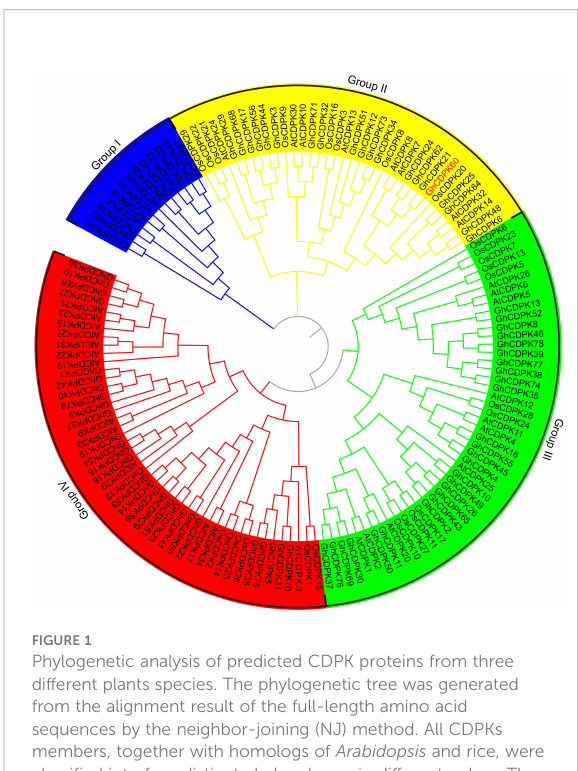
FIGURE 1 Phylogenetic analysis of predicted CDPK proteins from three different plants species. The phylogenetic tree was generated from the alignment result of the full-length amino acid sequences by the neighbor-joining (NJ) method. All CDPKs members, together with homologs of Arabidopsis and rice, were classi fi ed into four distinct clades shown in different colors. The pre fi xes At, Os and Gh are used to identify CDPK proteins from A. thaliana , O. sativa and G. hirsutum ,